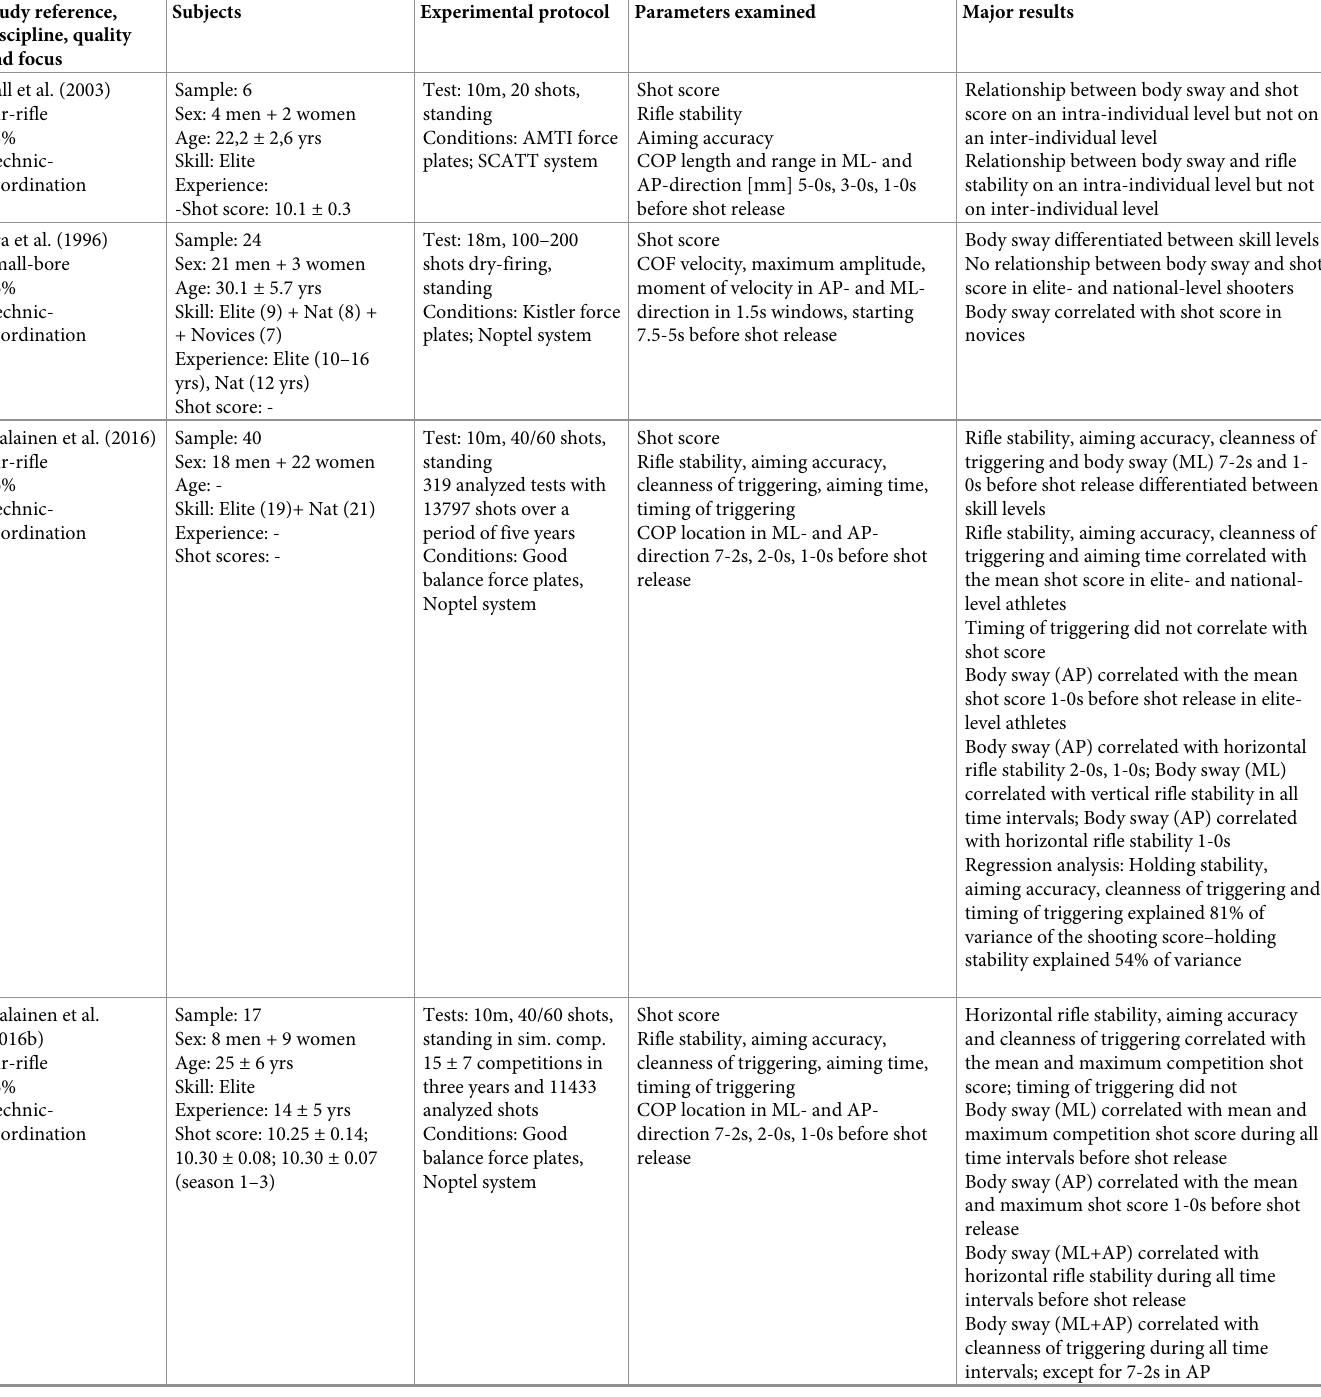
Table 1. Summary of the included articles (N = 14) with an overview of the quality scores, sample characteristics, experimental protocols, examined parameters and major results. Study reference, discipline,